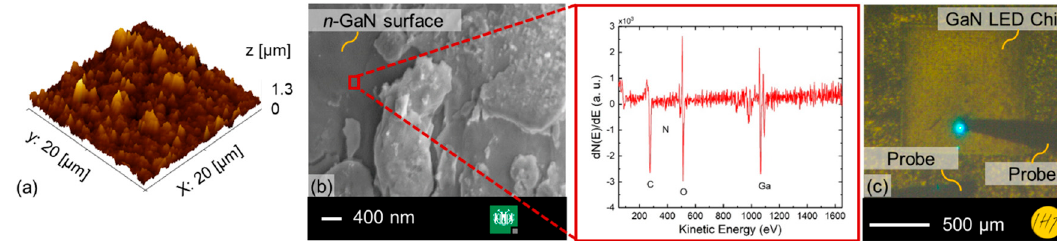
Figure 4. Surface characterization n-GaN surface after LLO ( a ) 3D AFM profiles of n-GaN surfaces ( b ) SEM images of sample and the AES survey spectra of n-GaN surface with a spot size of 400 nm and ( c ) EL measurement result using probing tip